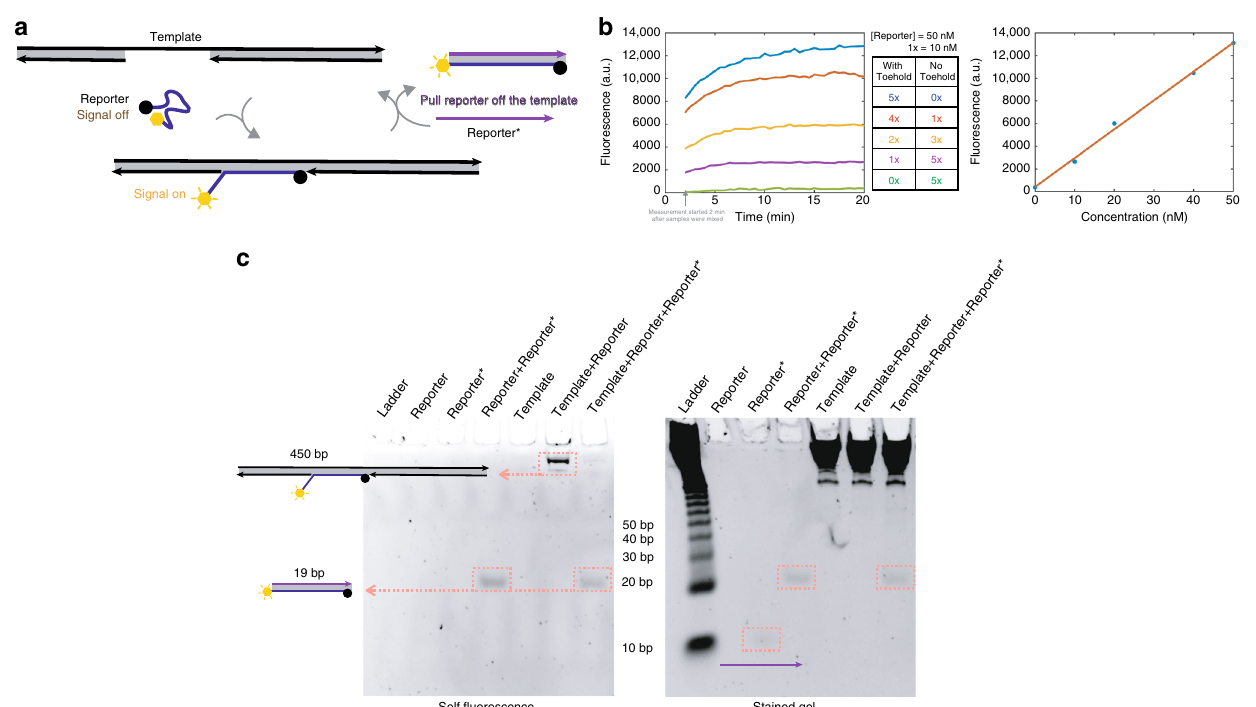
Fig. 4 Non-destructive bitwise random access. a Non-destructive detection of toeholds through a fl uorophore and quencher labeled Reporter strand. Once the Reporter hybridizes with the toehold on the register strand, a fl uorescence signal is observed due to the increase of the distance between the fl uorophore and quencher. The Reporter strand can be pulled off from the register once the Reporter* strand hybridizes with the Reporter. b Kinetics of detecting the concentrations of registers with and without toeholds in a mixtures (left). The fl uorescence signals saturate within 20 min. The samples were mixed no more than 2 min before measurement. The concentration of toehold-ed DNA can be accurately quanti fi ed through fl uorescence intensity (right), as it increases linearly with the concentration of the registers with toehold. c PAGE gel results for non-destructive detection of a toehold. Left: the gel was not stained with other fl uorescence dyes and hence only the species with self- fl uorescence are observed. After adding the Reporter, a large size complex appears in the lane “ Template + Reporter ” , indicating hybridization of the Reporter and the register. After the Reporter* is added, as seen in the lane “ Template + Reporter + Reporter* ” , the large size complex in the previous lane no longer exhibits self- fl uorescence, indicating that the Reporter strand is pulled off from the register. Right: The same gel after staining (with SYBR gold: ThermoFisher Scienti fi c). Note that the same molecular components are observed, in addition to the Reporter*. The PAGE analysis was performed once as this is a standard molecular computing setup and the results are expected to be consistent over many trials. Source data is available in the Source Data fi